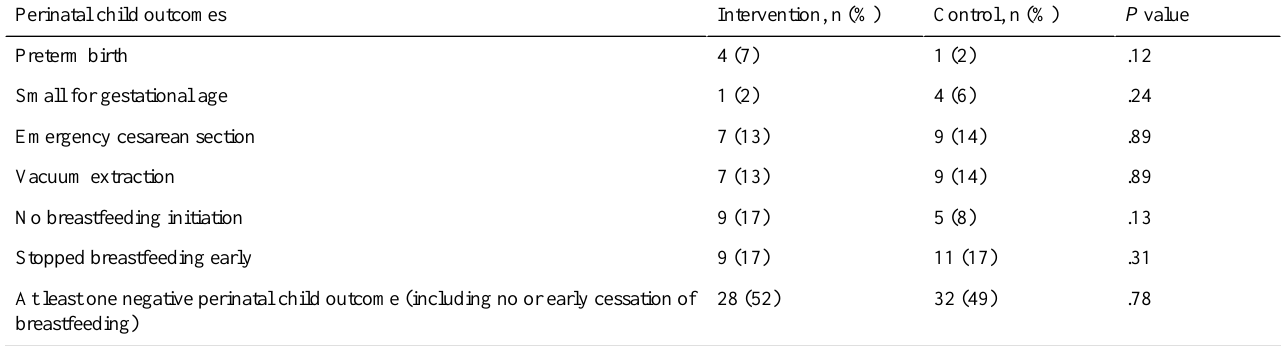
Table 4. Perinatal child outcomes in the intervention group compared with the control